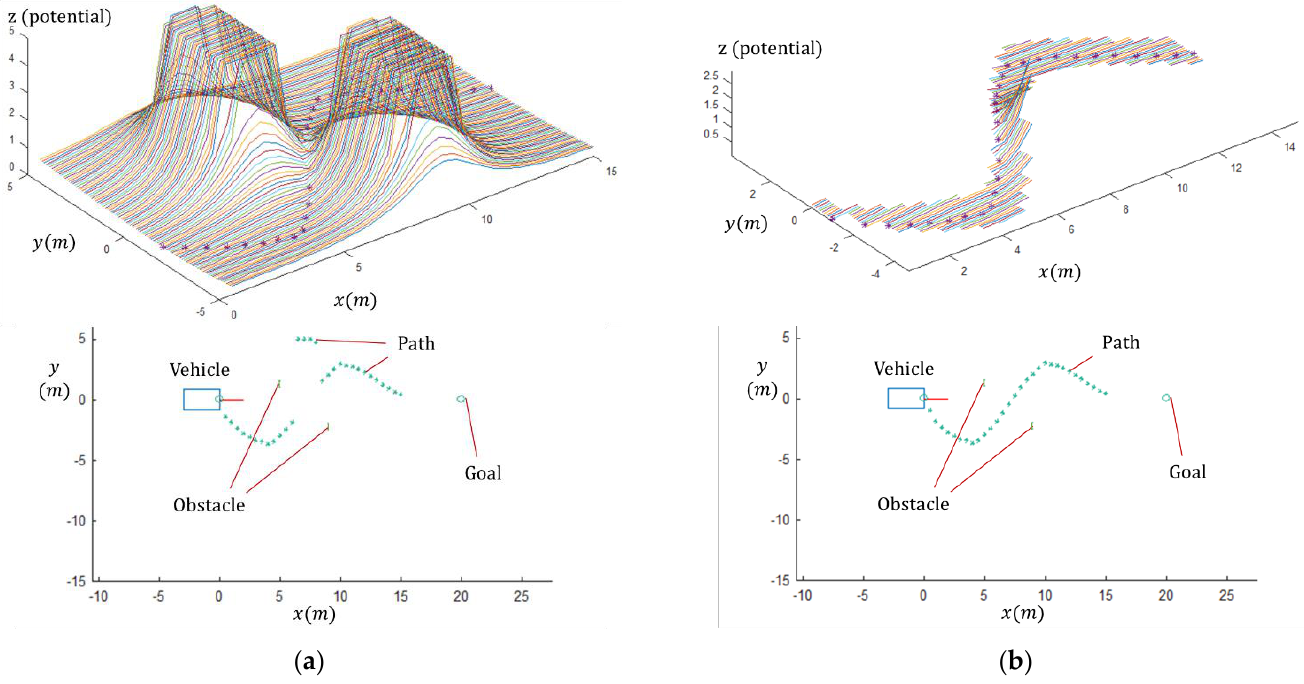
Figure 7. Potential field simulation: ( a ) simulation result of potential field algorithm with single obstacle; ( b ) simulation result of modified potential field algorithm with single obstacle.